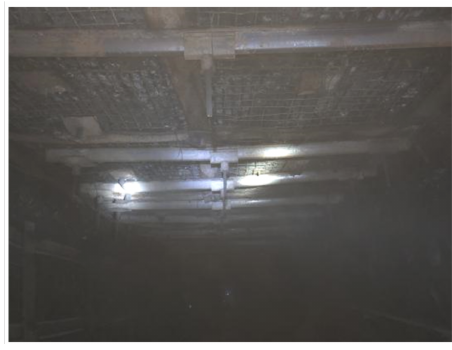
Figure 17. Effect of support onsite.